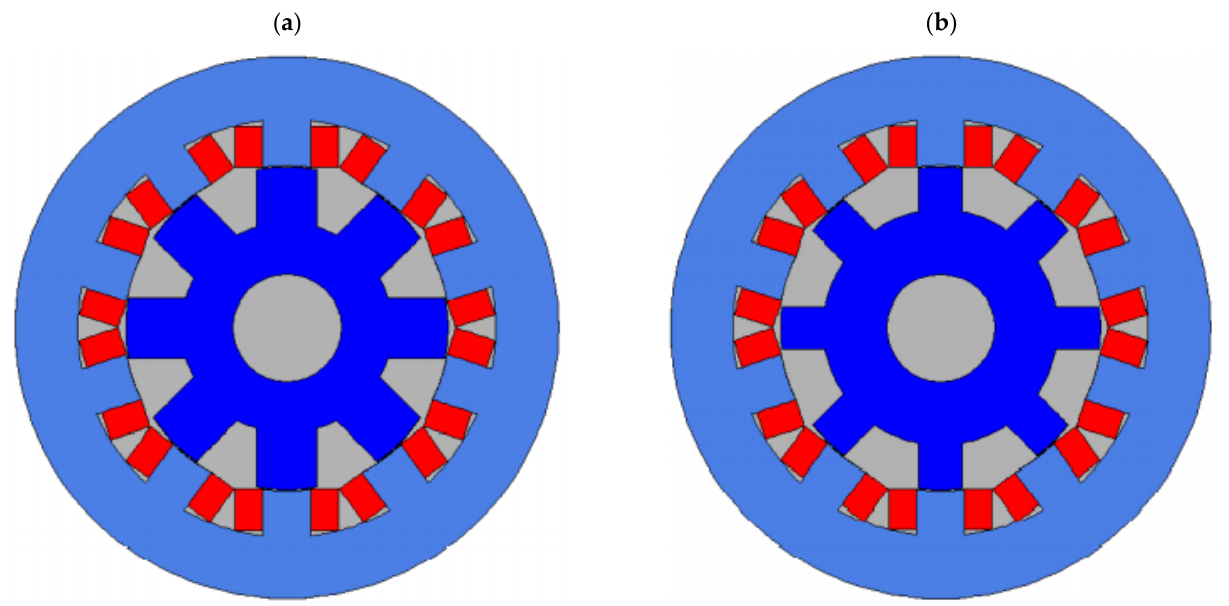
Figure 21. A 10/8 motor model with a modified rotor: ( a ) Motor model for the rotor #1 with bps = 18, hps = 16.8; ( b ) Motor model for the rotor #2 with bps = 12, hps = 12.8.